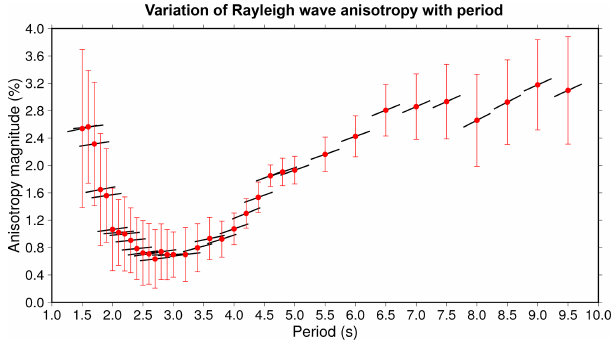
Figure 9. Variation of 2 θ Rayleigh wave anisotropy with period in the Izmit–Adapazari region. The red dots are the measured magni- tude of anisotropy at each period, and the corresponding uncertainty is the standard deviation of the anisotropy magnitude taken from the covariance matrix during the curve-fitting process described in Sect. 3.6. The black lines indicate the angle from north of the 2 θ fast direction at each period, and the top of the plot represents